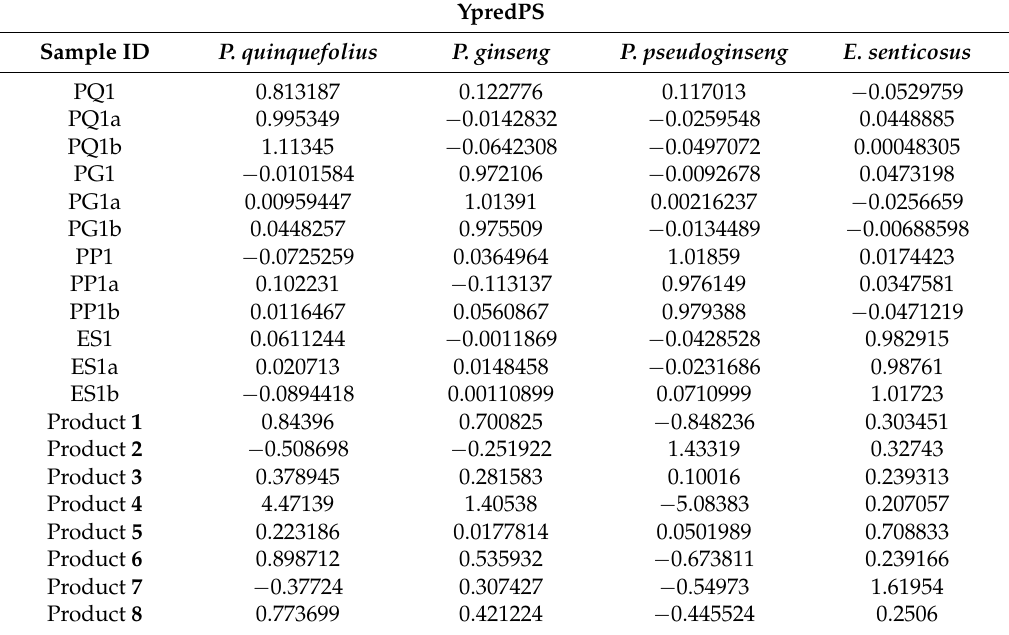
Table 3. Classification list showing predicted Y-values (YPredPS) for both the work set (reference materials) and prediction set (commercial products) based the OPLS-DA model developed using NIR